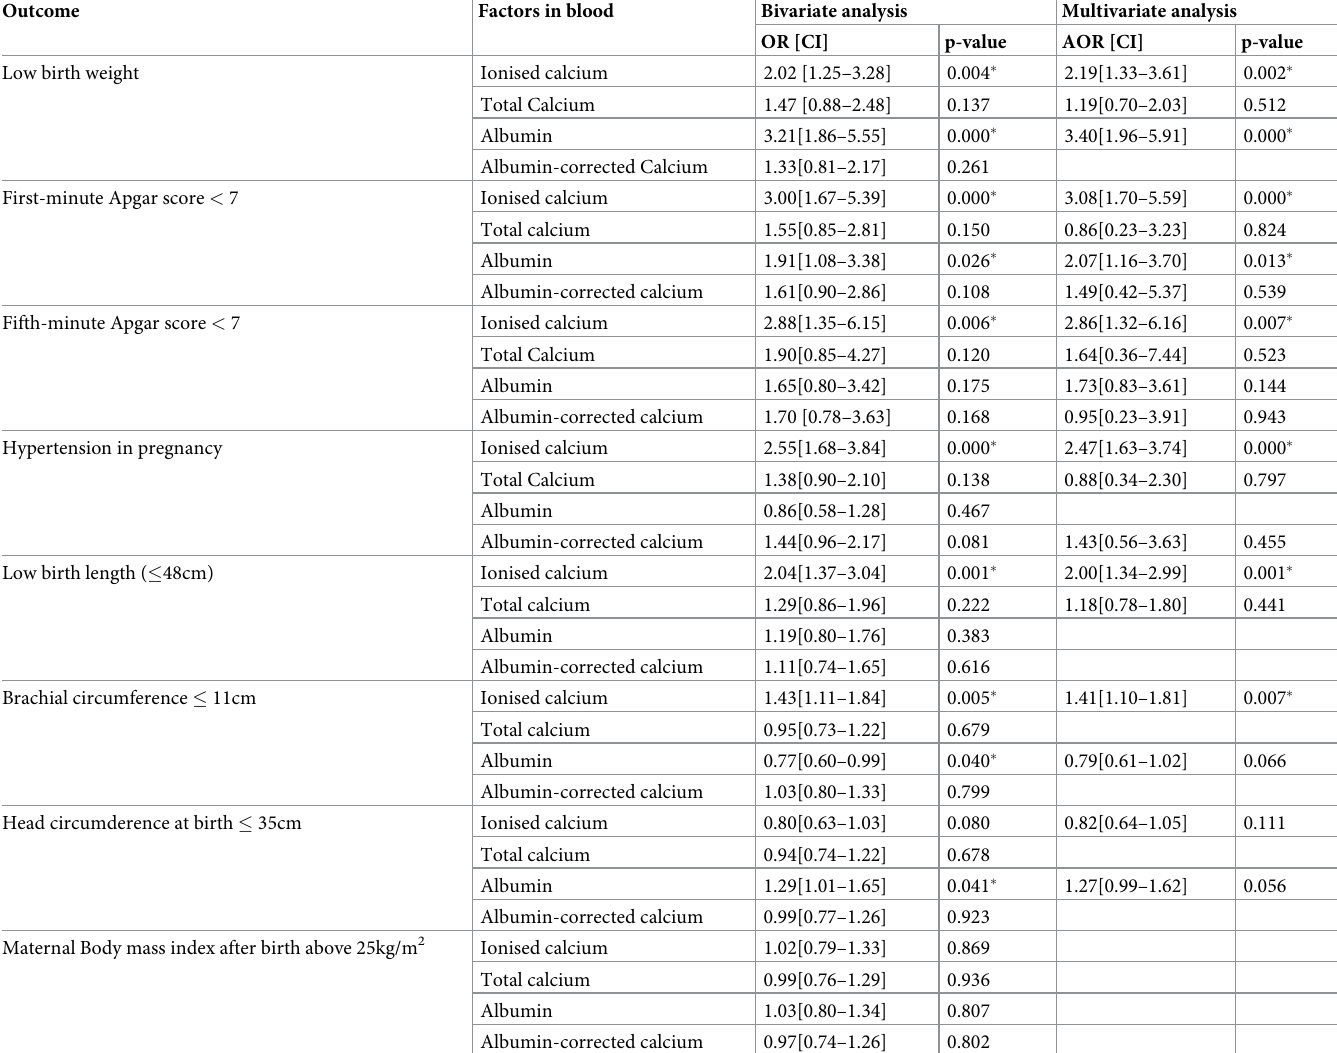
Table 2. Association of ionised, total calcaemia and albuminaemia with maternofoetal outcomes.